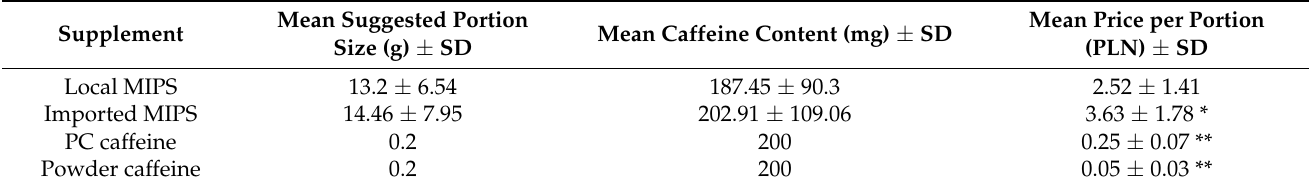
Table 4. Supplement portion size, caffeine content and price per portion